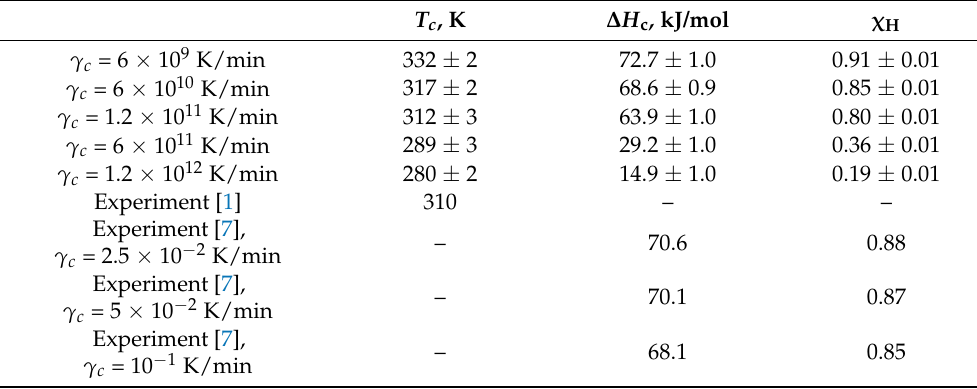
Figure 1. ( a ) Mass density ρ of n ‐ eicosane samples as a function of temperature T for different cool ‐ ing rates. Error bars (standard errors) are of the size of symbols and are not shown. For the sake of comparison, the experimental data [20,21] are also shown. ( b ) Molar specific heat capacity C p as a function of temperature for different cooling rates. The peaks corresponding to the crystallization of n ‐ eicosane samples are marked by arrows. Table 1. The crystallization temperature T c , the crystallization enthalpy Δ H c , and the crystallinity χ H = Δ H c / Δ H ideal (where Δ H ideal = 80.3 kJ/mol is the crystallization enthalpy for an ideal n ‐ eicosane crystal [23]). χ H = ∆ H c / ∆ H ideal (where ∆ H ideal = 80.3 kJ/mol is the crystallization enthalpy for an ideal n-eicosane crystal [23]).